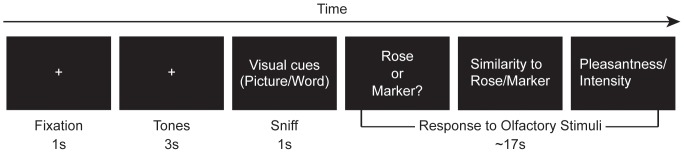
Illustration of an experimental trial.Each trial began with a fixation (1 s) followed by 2 low tones and 1 high tone (1 s each) that prepared and prompted the subjects to take a single sniff of a pair of bottles at the end of the high tone for the duration (1 s) of a visual stimulus (picture/word) while maintaining fixation on the visual stimulus. Subjects subsequently indicated whether they smelled predominantly “rose” or “marker,” and rated its similarity to the rose and marker smells, as well as its intensity and pleasantness on separate VASs with ‘not at all’ on one end of the scale and ‘extremely’ on the other end.